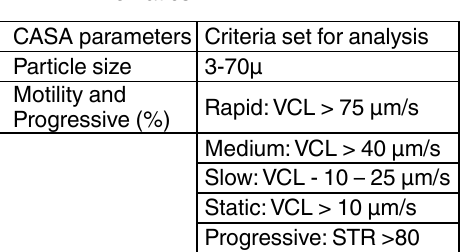
table 2 . Settings in computer assisted sperm analysis for the assessment of